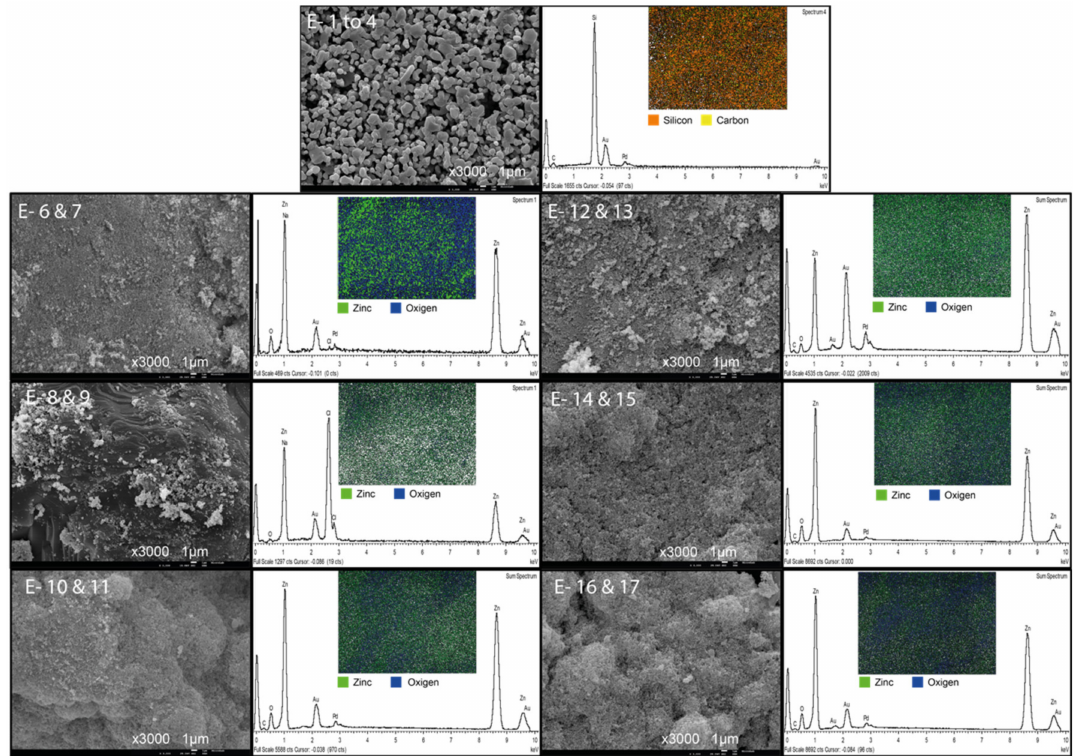
Figure 4. Catalyst distribution on modified membranes using EDS mapping made over SEM images.